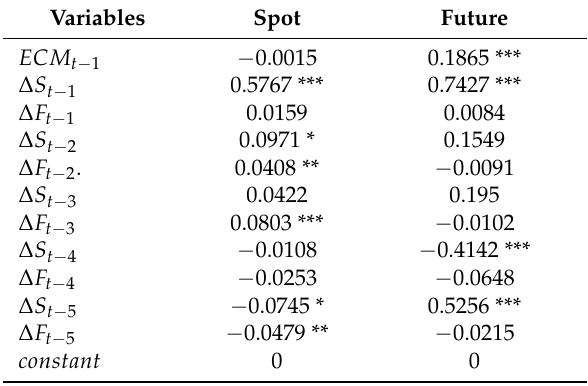
Table 5. Vector error correction model VECM—Ethanol prices.